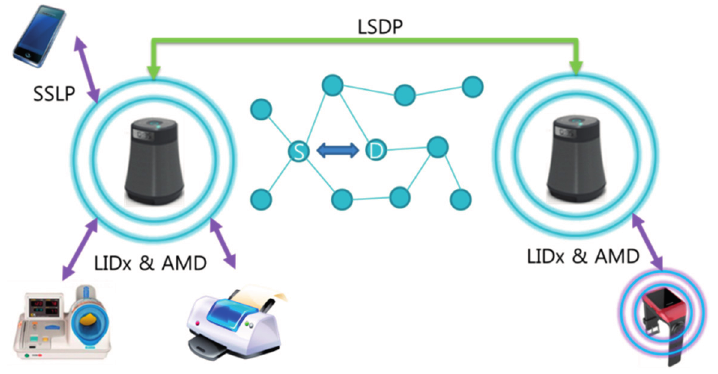
Figure 5. Protocols to support iLBSs in the proposed